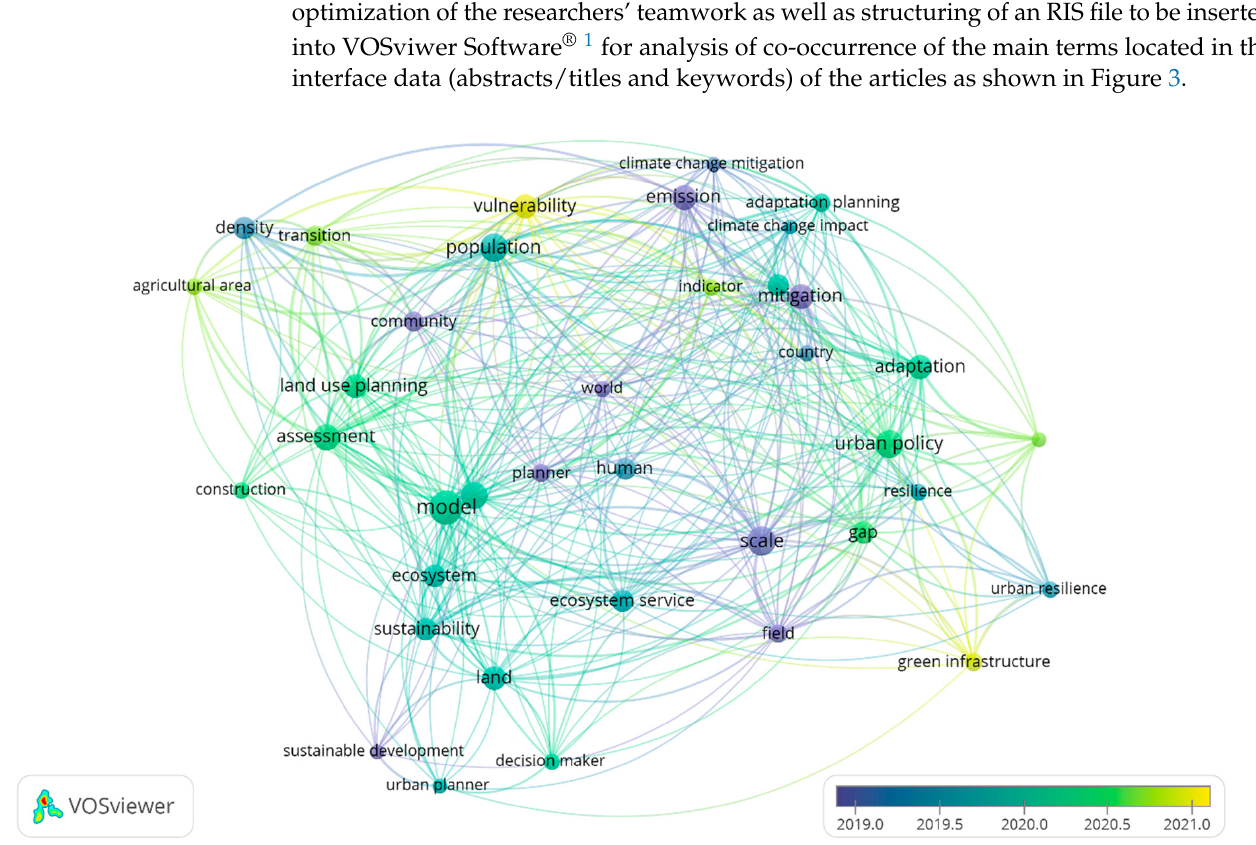
Table 1. Description of results by database/indexers.